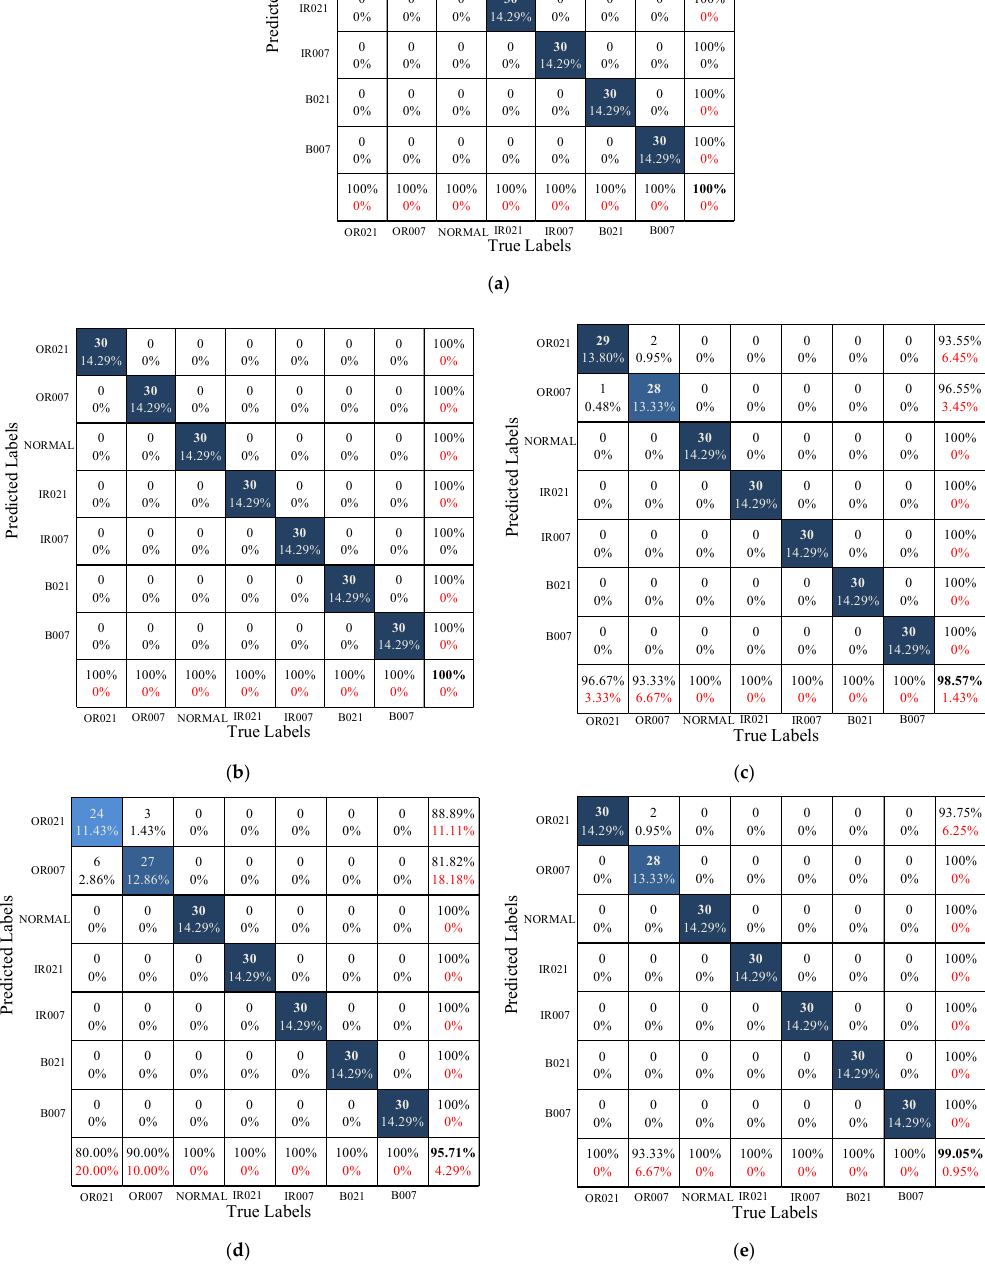
Figure 10. Confusion matrix charts of fault diagnosis results obtained by different approaches: ( a ) ResNet34 ‐ TL; ( b ) MobileNet ‐ TL; ( c ) ResNet34; ( d ) MobileNet; ( e ) CNN.